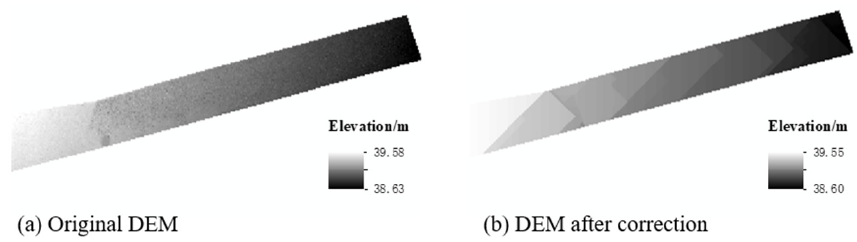
Figure 10. Correction of DEM results.